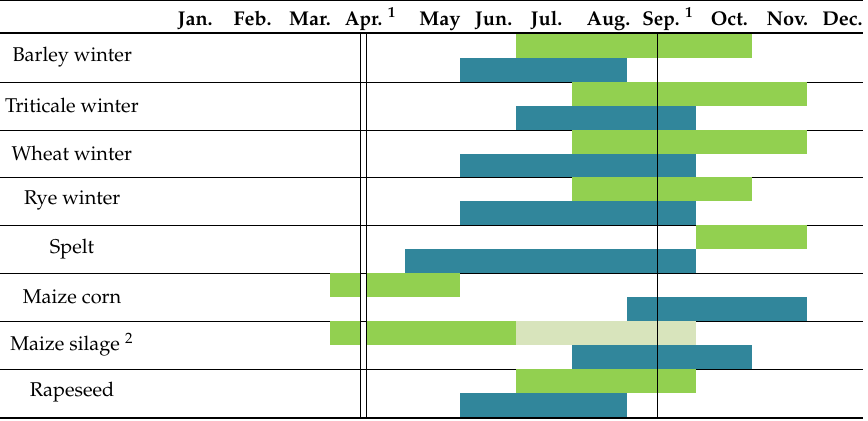
Table 1. Sowing and harvest periods for the dominant crops (winter cereals, maize, and rapeseed) in the study